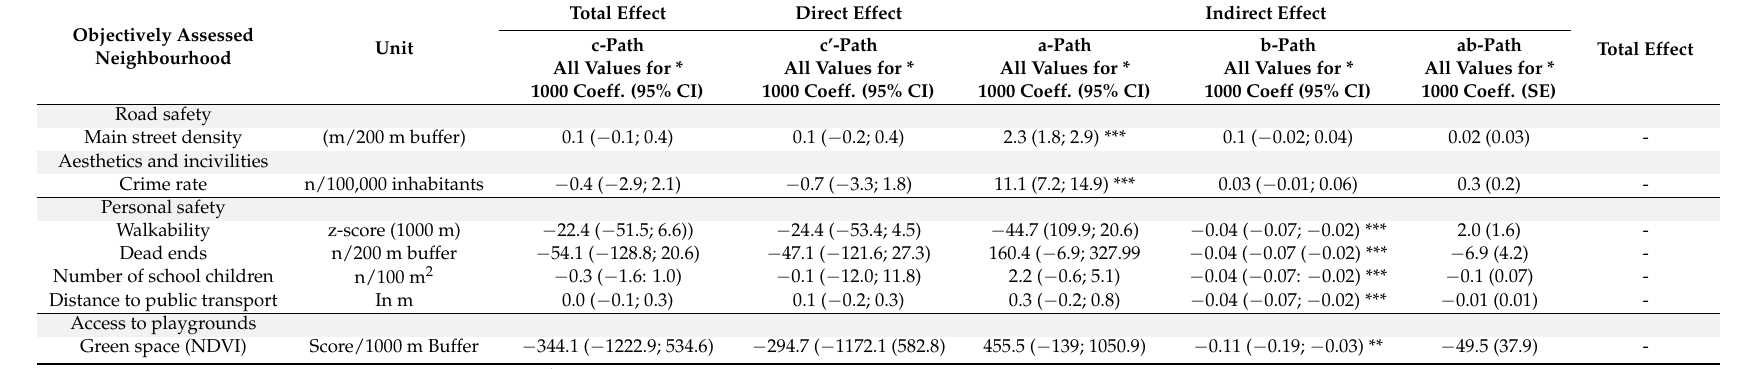
Table 4. Mediation of the associations between the objectively assessed environment and children’s SB in the weekend by the perceived environment.